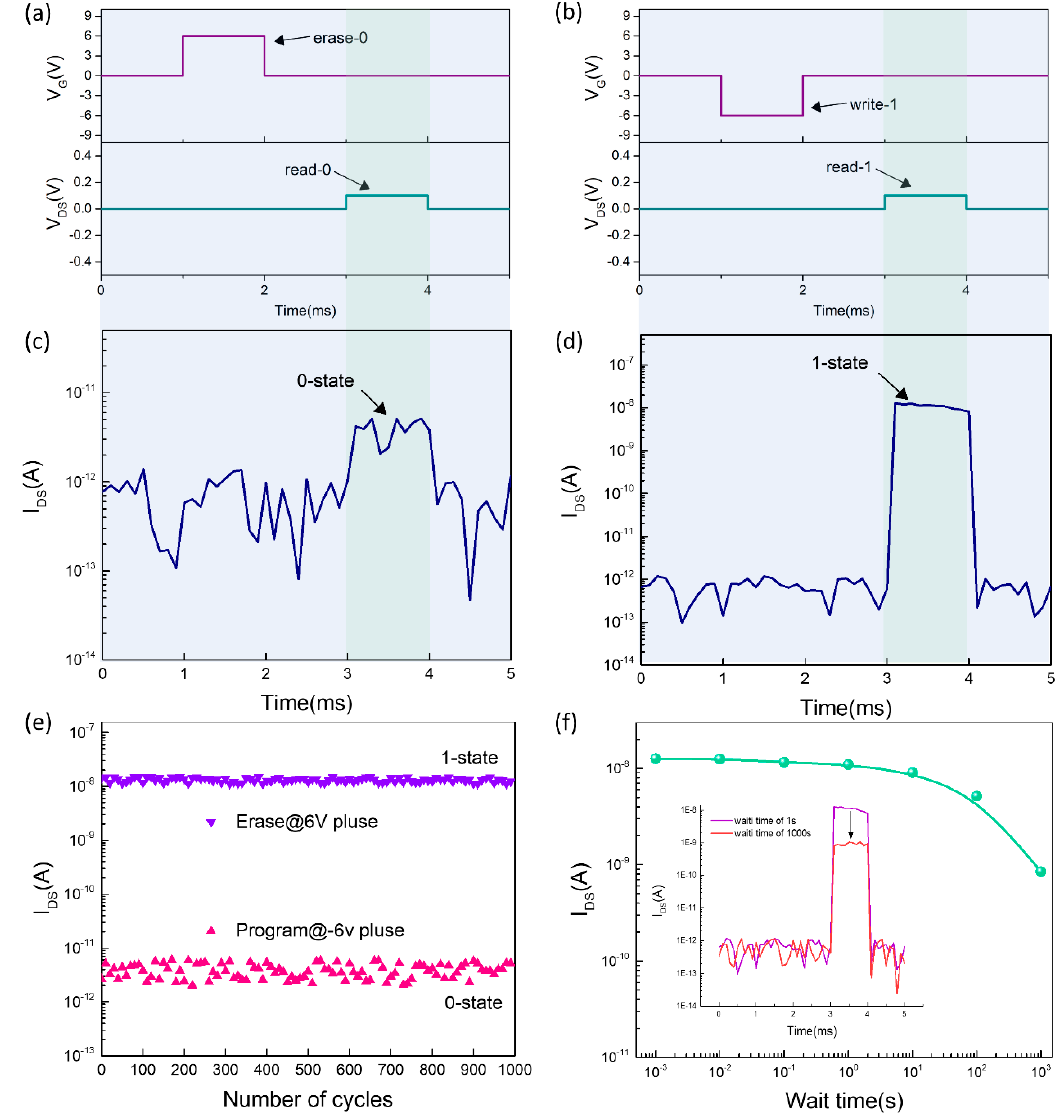
Figure 3. Demonstration of the write/erase operation. ( a , c ) The erase operation with +6 v pulse signal and read 0-state, respectively. ( b , d ) The program operation with − 6 v pulse signal and read 1-state, respectively. ( e ) The endurance testing of memory cell in 1000 cycles, and no performance reduction is observed. ( f ) The exponentially decay characteristic with wait time increasing. The refresh time of 100 s is obtained from the decay curve. The inset of ( f ) shows the output signal degradation when the wait times increase from 1 to 100 s.